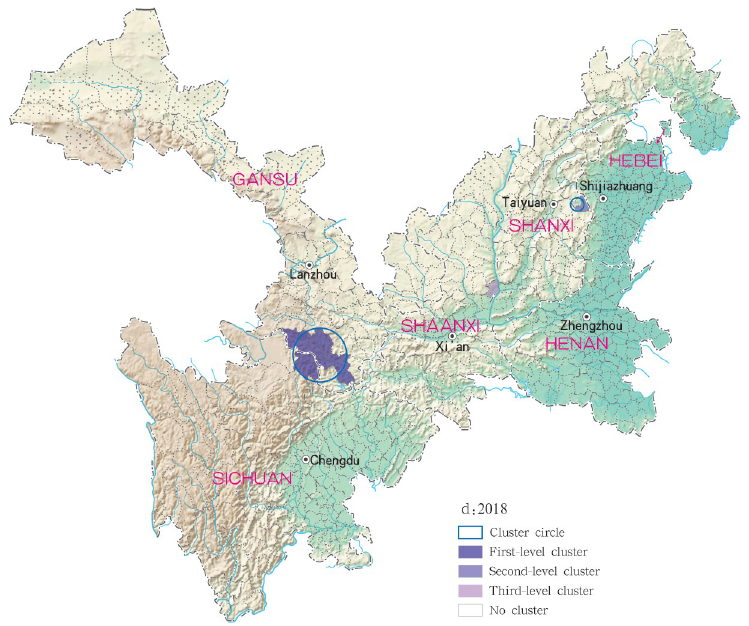
Fig 14. Spatio-temporal clustering analysis of mountain-type zoonotic visceral leishmaniasis incidence in 6 provinces, China in 2018.